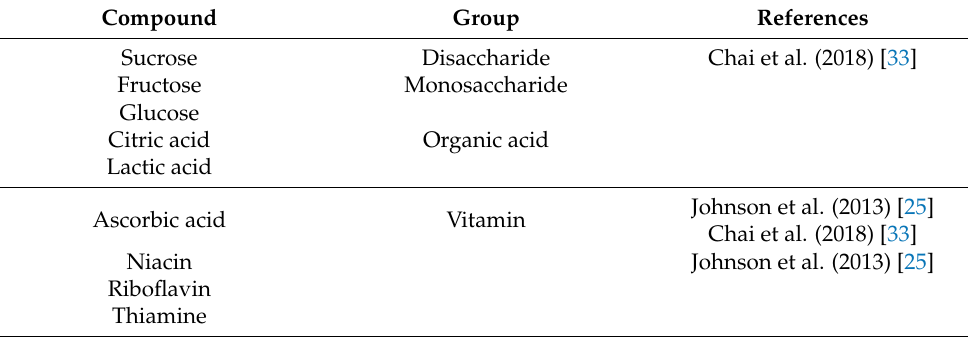
Table 3. Chemical compounds from N. lappaceum